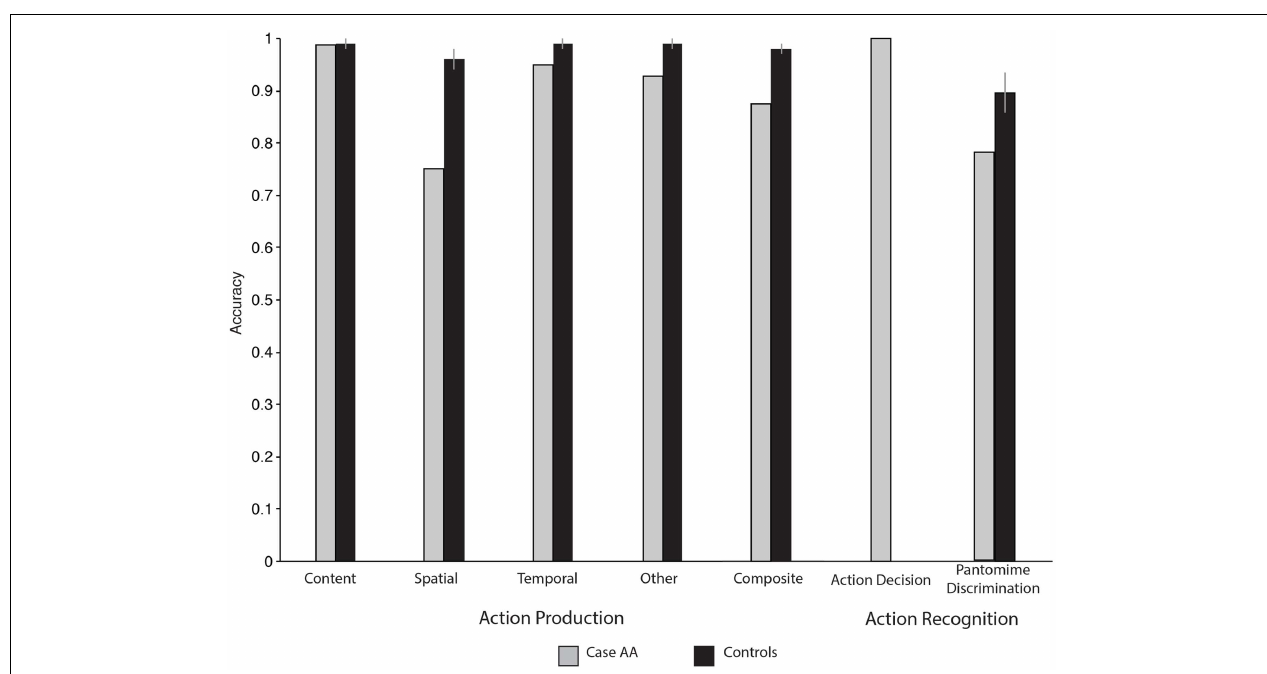
FIGURE 2 |The dissociation between CaseAA’s ability to produce meaningful actions and CaseAA’s ability to recognize meaningful